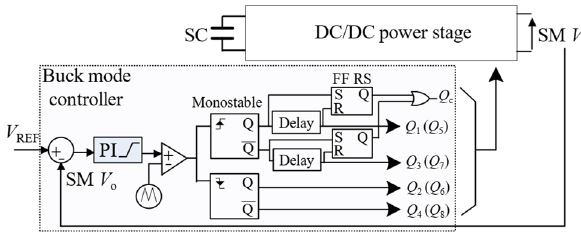
Figure 7. Buck-mode Controller.